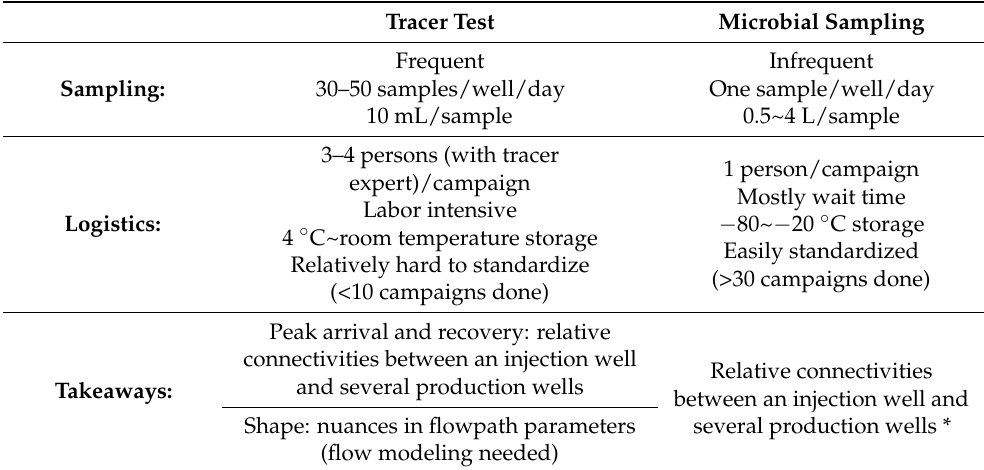
Table 3. Comparison between tracer test campaigns versus microbial sampling campaigns throughout the 10-month flow test. Tracer Test Microbial